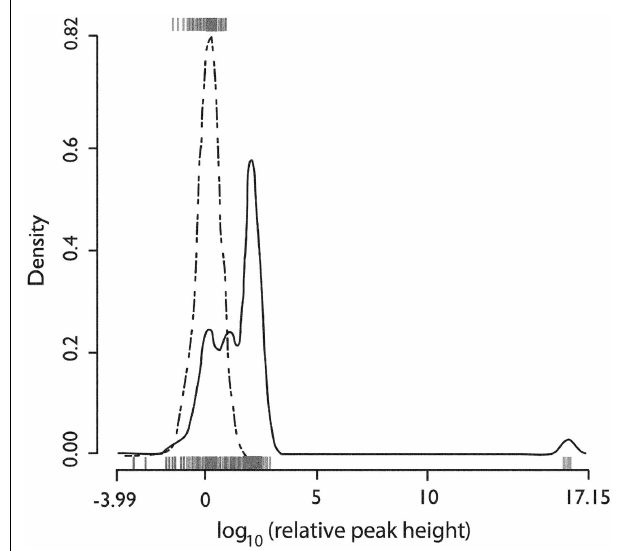
FIGURE 5 | Distributions of the relative height of the cross-correlogram peak at 0 delay for all recorded pairs of neurons .The distribution for positive peaks is shown by the rug plot on the lower x -axis with an estimated density shown by the solid line (Gaussian kernel with SD = 0.25). The distribution for negative peaks is shown by the rug plot on the upper x -axis with estimated density shown by the dotted line (Gaussian kernel with SD = 0.25). X -axis is the base 10 logarithm of the absolute value of the peak height relative to the standard deviation of cross-correlogram values in a window from 1 to 25ms delay. Used with permission from Barrow Neurological